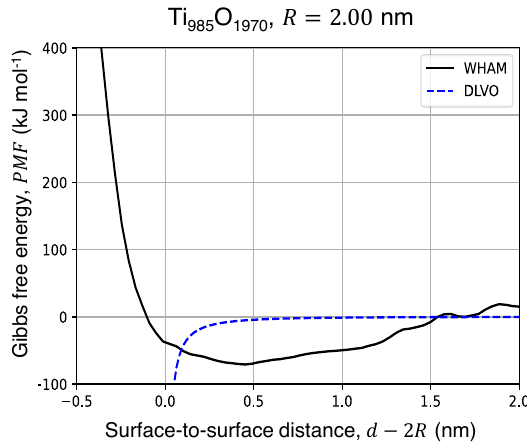
O NPs and ( C ) a pair of Ti 417 834